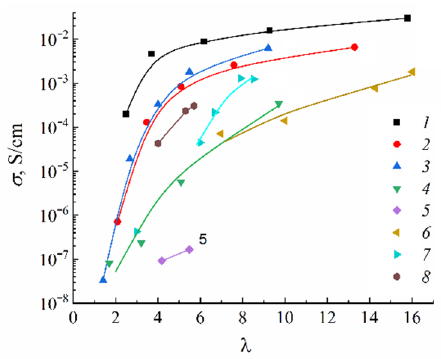
Figure 25. Conductivity dependence on the moisture content for sulfonate cation-exchange resin MF-4SC (1–4) and carboxylic F-4CF (5–8) perfluorinated membranes in various ionic forms. Membrane ionic forms: (1, 5) H + , (2, 6) Li + , (3, 7) Na + , (4, 8) Cs + . Adapted from [24,38].